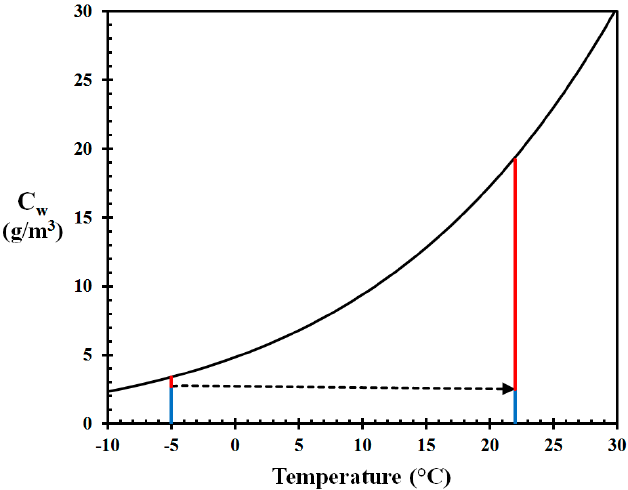
Figure 1. Saturation concentration of water (in air) [30] as a function of temperature (Air at − 5 °C